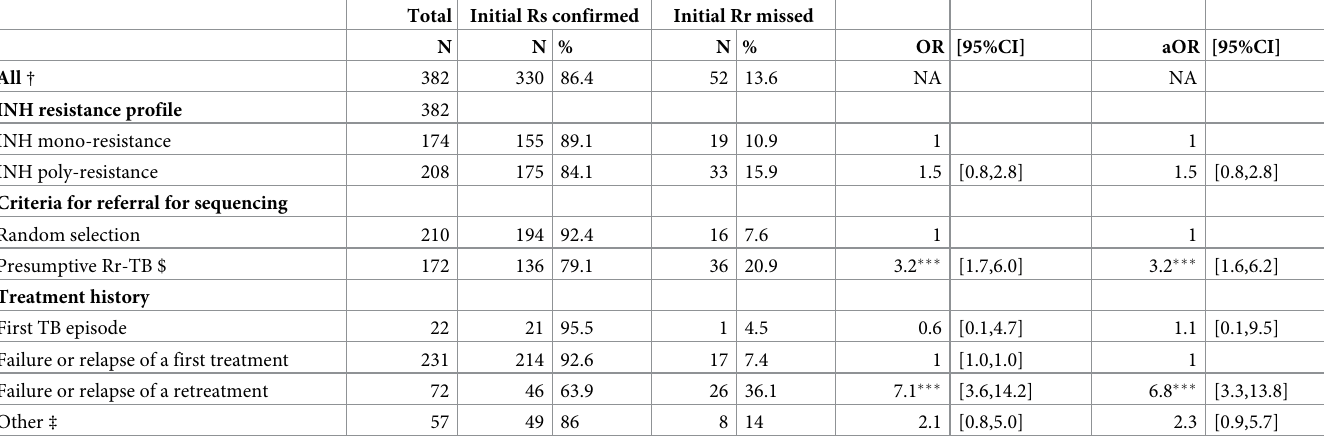
Table 4. Missed initial rifampicin resistance, among 382 patients with initial rifampicin-susceptible/isoniazid-resistant TB on phenotypic